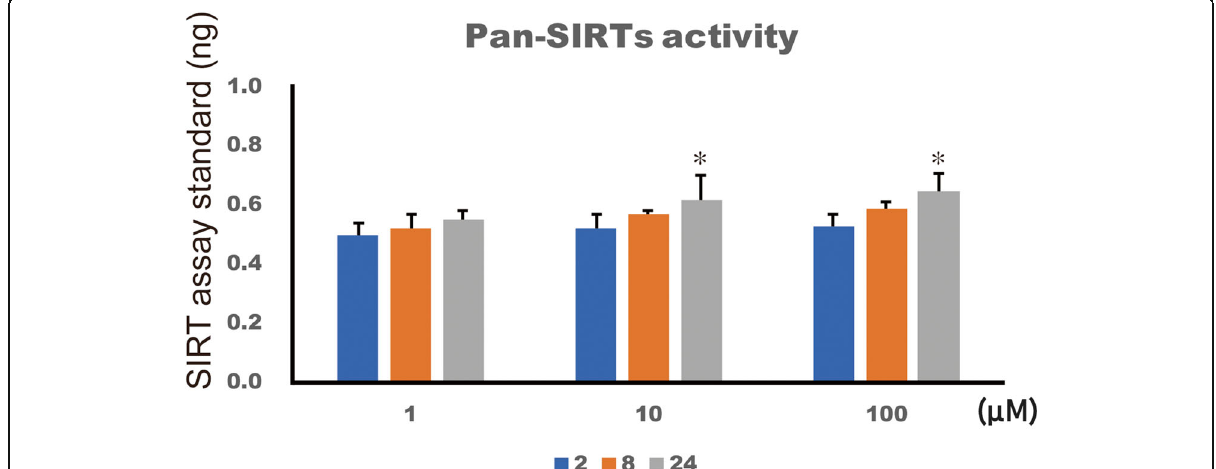
Fig. 2 Pan-SIRT activity. Pan-SIRT activity was significantly increased in the 10 and 100 μ M 4HR groups at 24 h after administration compared to that of the untreated control (* p <